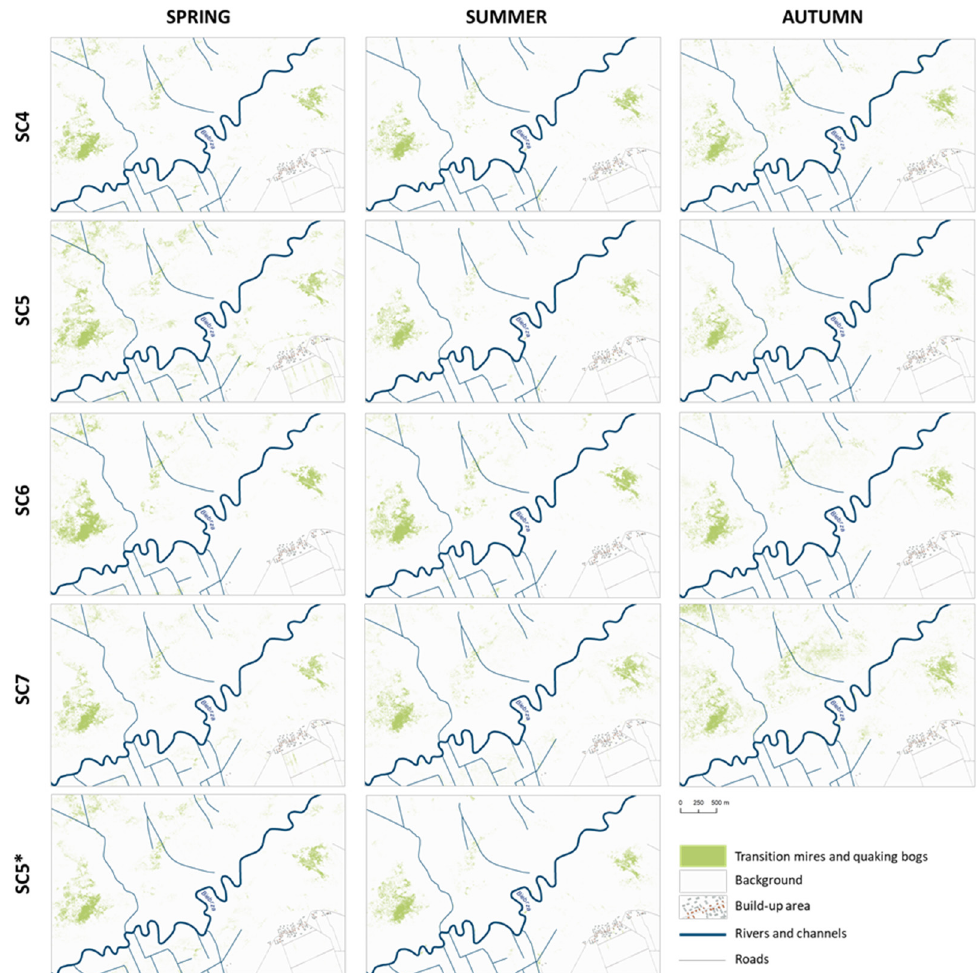
Figure 10. An example of comparison of classification results for transition mires and quaking bogs in the UB area in spring, summer, and autumn campaigns for five scenarios in level 2 (SC4, SC5, SC5*, SC6, and SC7).